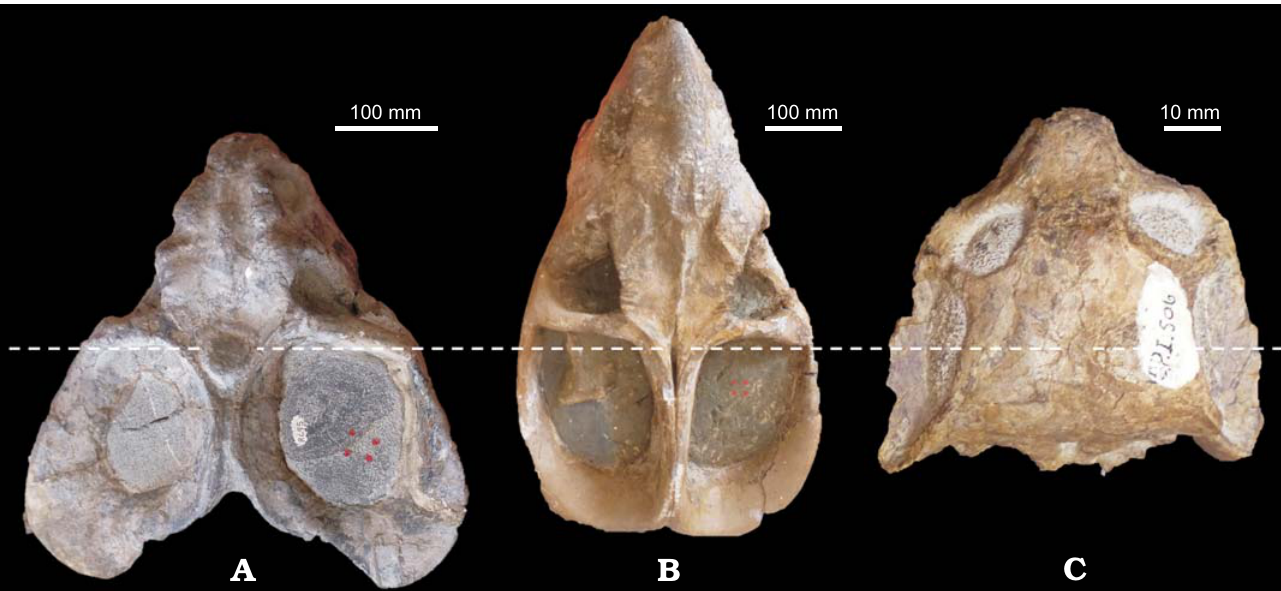
Fig. 4. Skulls of Dicynodontia illustrating the great variability of the shape and size of parietal foramen in Therapsida. A . Large and circular parietal foramen, with a pineal boss in Rachiocephalus , RC 95, Derdedrif, Adendorp, South Africa, Cistecephalus – Tropidostoma AZ, 260–255 Ma. B . Slit-like parietal foramen in Dinanomodon , RC09, Stylkrans, South Africa, Cistecephalus AZ, 250–255 Ma. C . Absent foramen in Cistecephalus , BPI/1/506, Towerwater, Murraysburg, South Africa, Cistecephalus AZ, 250–255